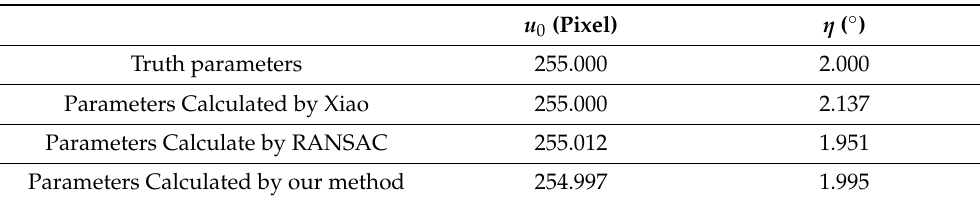
Table 2. The calibration parameters in the Head data compared with the true value, Xiao [18], RANSAC and ours.